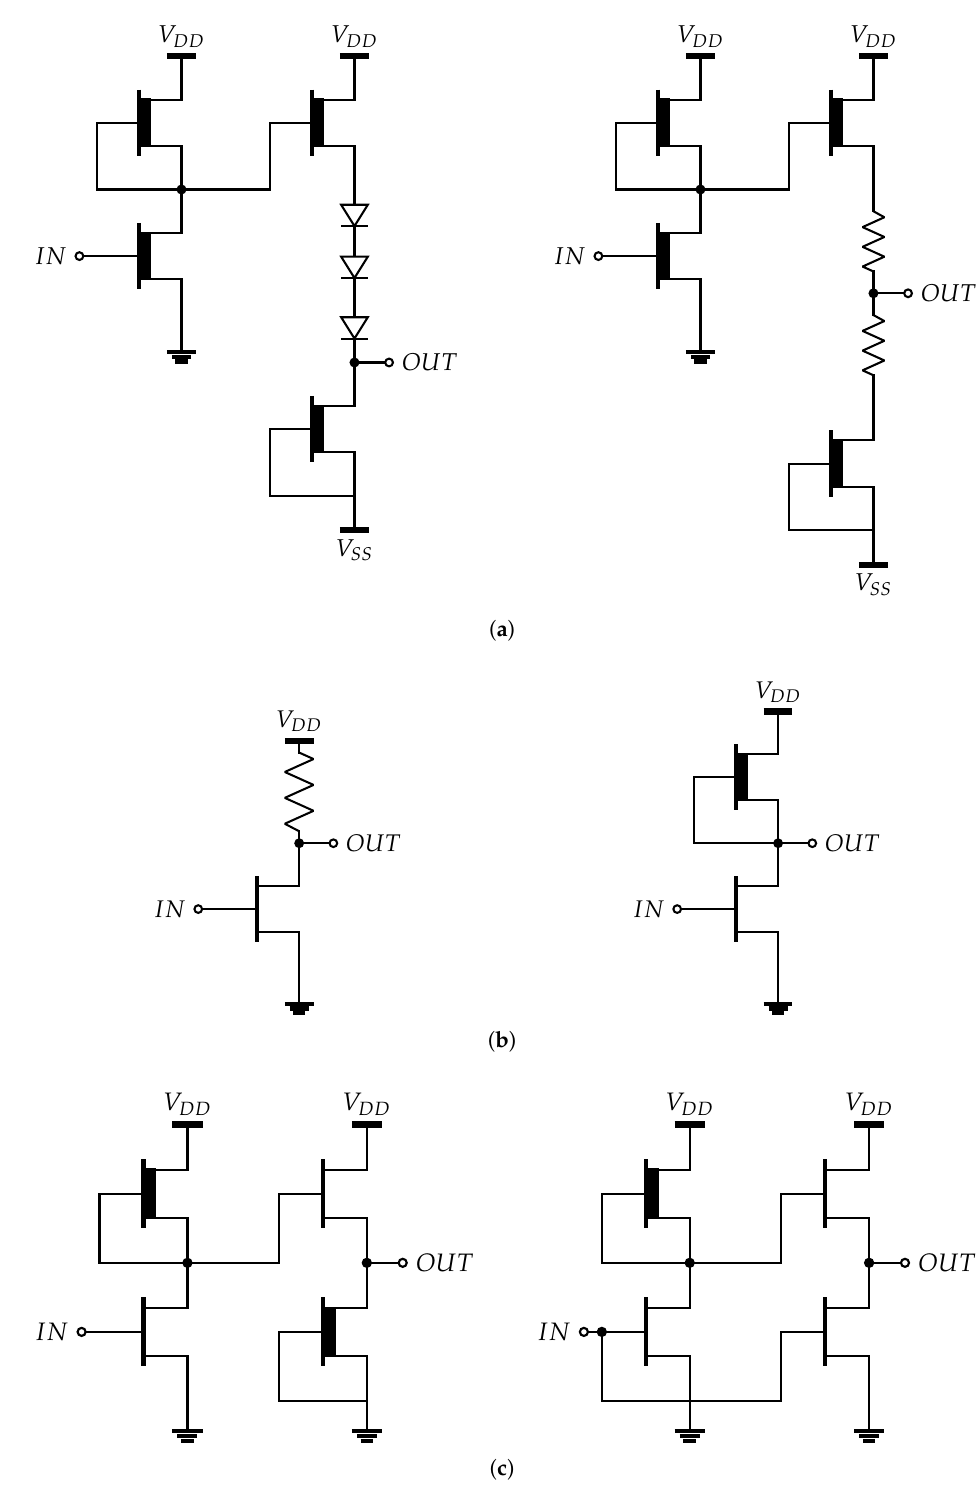
Figure 3. Inverter gate ( OUT = IN ) implementations in different FET logic families. ( a ) D- mode buffered FET logic: ( left ) origial scheme (D-BFL) and ( right ) HVR-shifter version (HVR- BFL). ( b ) Direct-coupled FET logic: ( left ) E-mode scheme (E-DCFL) and ( right ) E/D mode scheme. ( c ) Buffered E/D-mode logic: ( left ) output source-follower buffered (BDCFL/EDSF) and ( right ) super-buffered